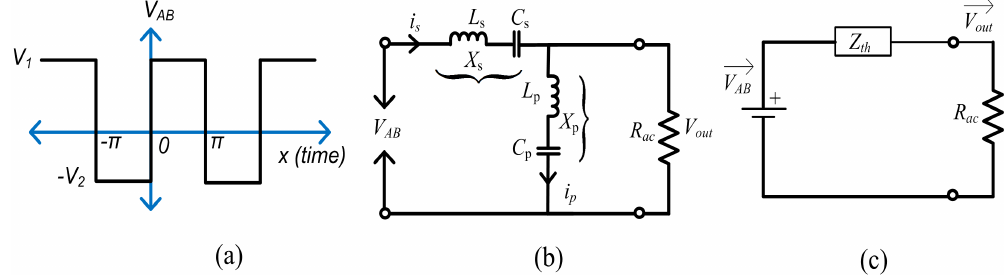
Figure 3. ( a ) Voltage across terminals AB; ( b ) Converter AC equivalent circuit; ( c ) Thevenin’s equivalent